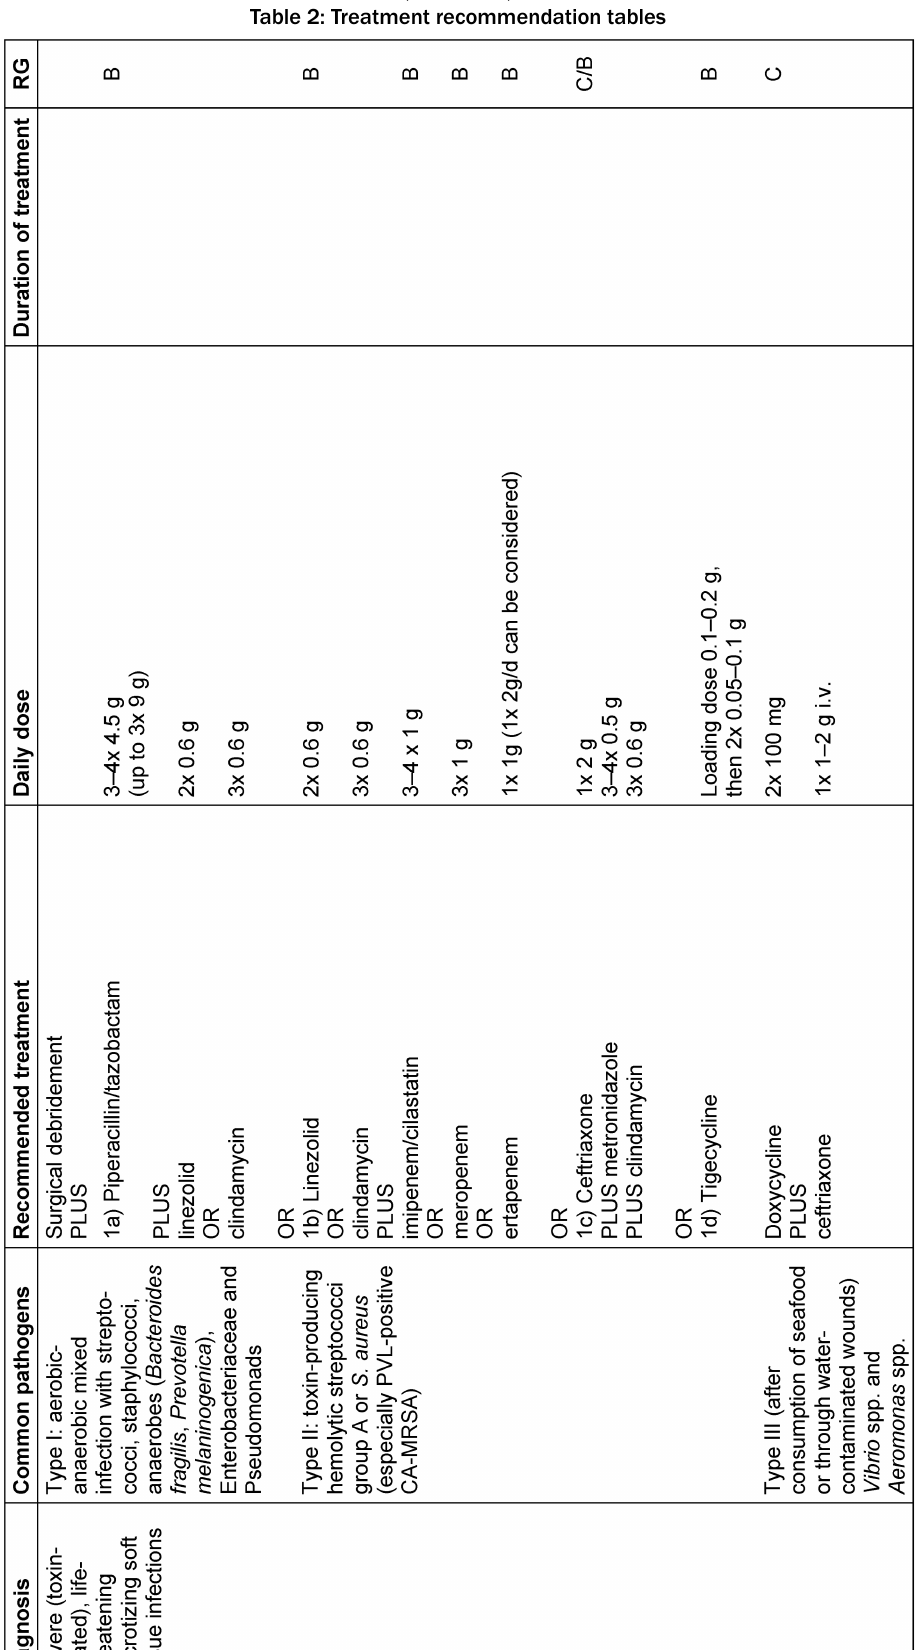
Table 2: Treatment recommendation